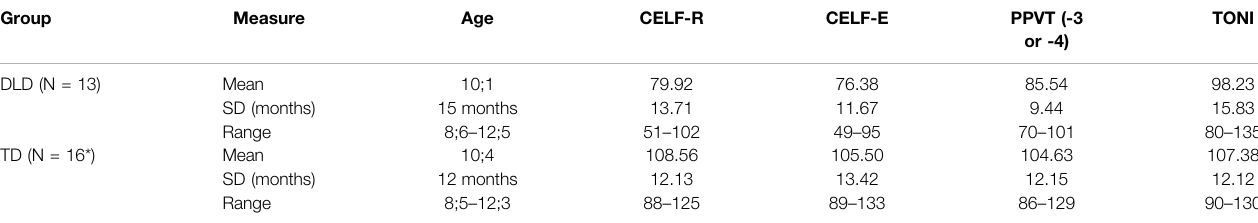
TABLE 1 | Participant pro fi les with standard scores.